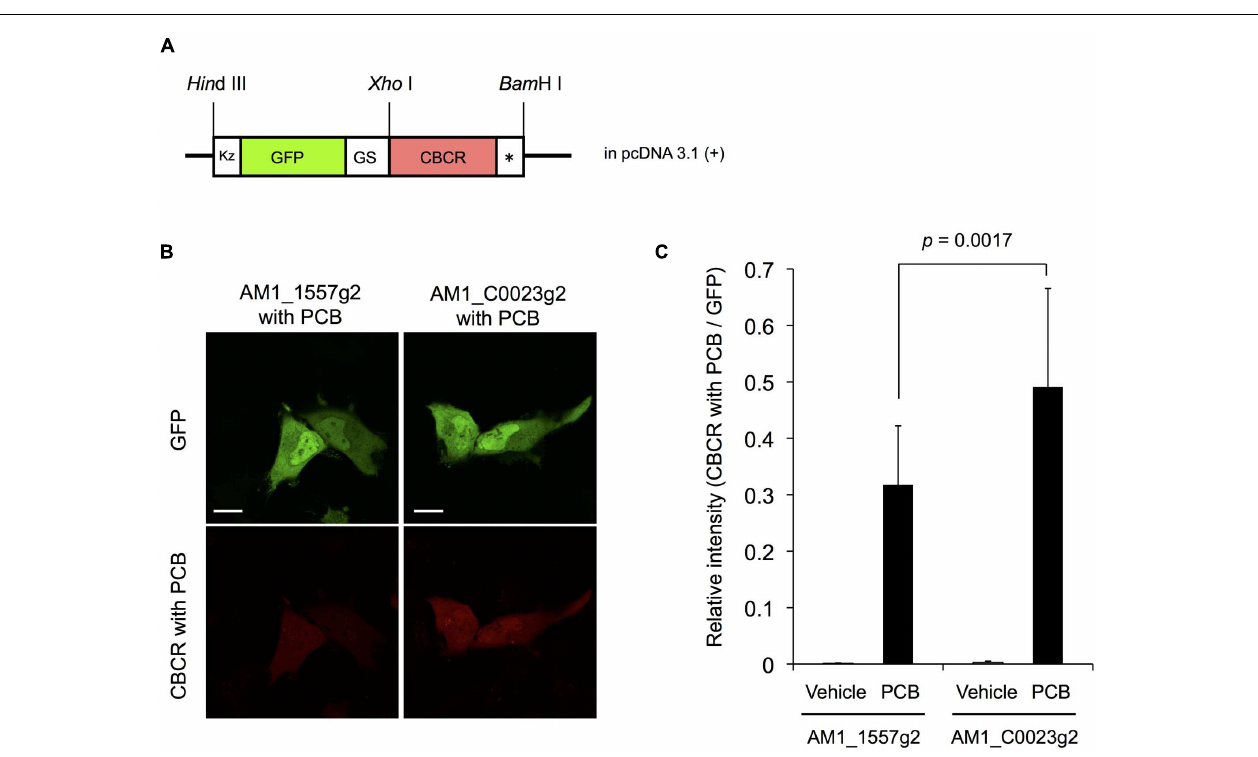
FIGURE 9 | Expression of GFP-fused AM1_1557g2 and AM1_C0023g2 in mammalian cells. (A) Schematic diagram of plasmid construct of GFP-fused AM1_1557g2 and AM1_C0023g2. Kz, Kozak sequence for efficient translation in mammalian cells; GS, a flexible peptide linker sequence (Gly-Gly-Ser-Gly-Gly); CBCR, AM1_1557g2 or AM1_C0023g2; ∗ , stop codon. (B) Representative confocal fluorescence images of GFP-fused AM1_1557g2 with PCB and AM1_C0023g2 with PCB. Left column, GFP-fused AM1_1557g2 with PCB; right column, GFP-fused AM1_C0023g2 with PCB; green images, GFP fluorescence; red images, fluorescence of CBCR with PCB. Scale bars, 20 µ m. (C) Relative intensity of fluorescence of CBCR with PCB normalized to GFP fluorescence. Error bars represent standard deviations ( n = 16, 16, 16, and 17 for AM1_1557g2 with vehicle, AM1_1557g2 with PCB, AM1_C0023g2 with vehicle and AM1_C0023g2 with PCB,